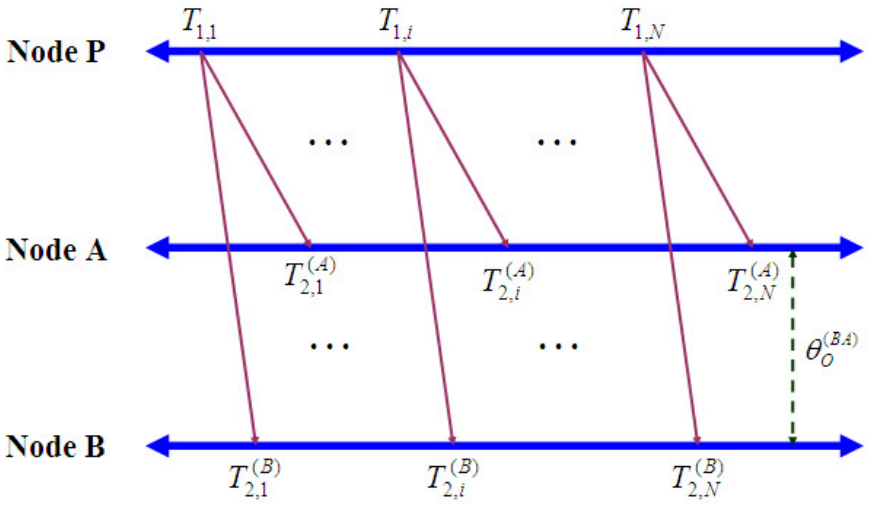
Figure 4. A clock synchronization model for the receiver-receiver synchronization approach (Node A and Node